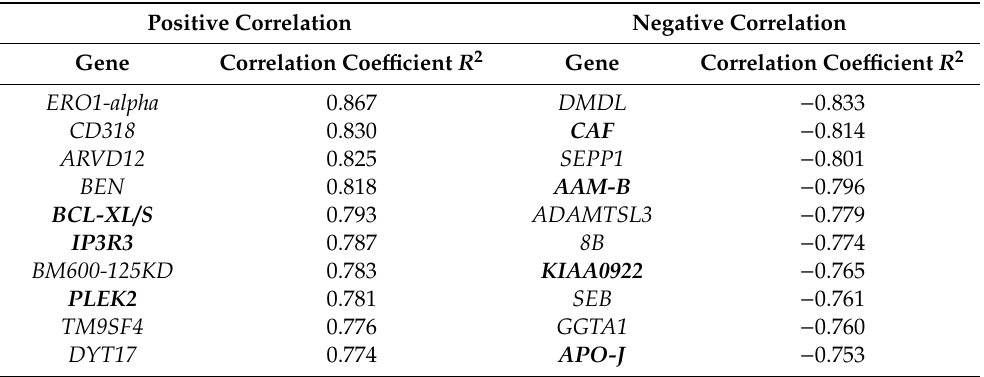
Table 1. Genes correlating with IMP2 expression. Table shows correlation coe ffi cients for